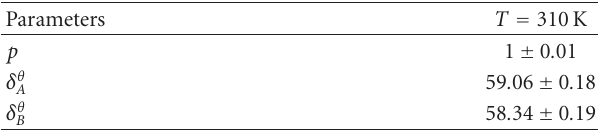
Table 1: Binding parameters for HSA+Cu 2+ interaction. Posi- tive and large δ θ A and δ θ B values indicate that Cu 2+ could a ff ect the structure of HSA strongly and stabilize the HSA structure significantly.